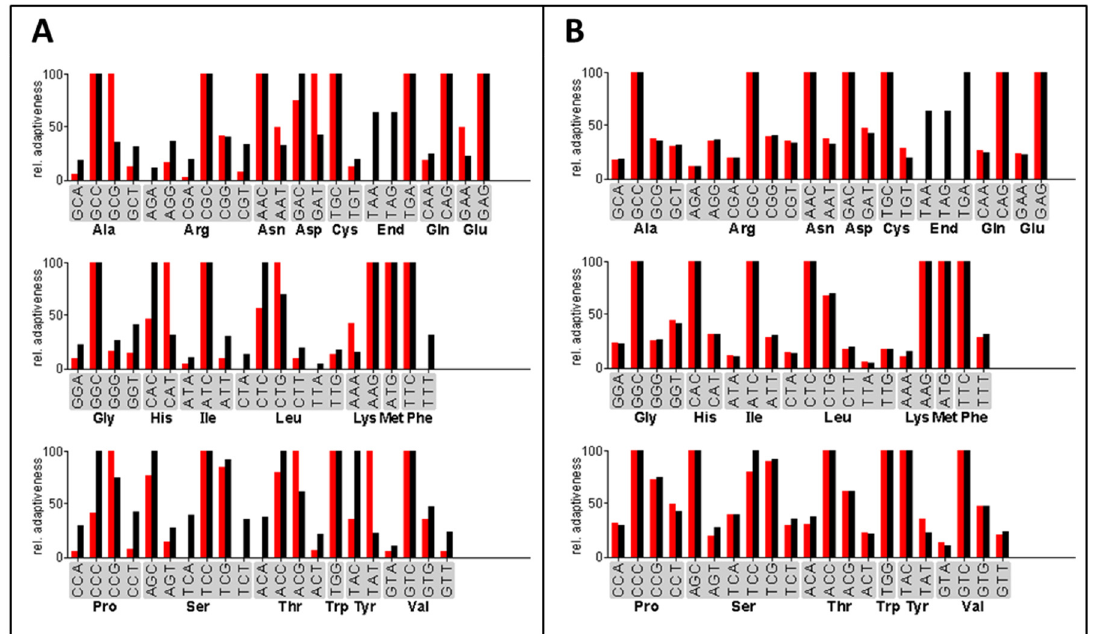
Figure 1. Example of the codon-optimizing process. Shown is the codon usage between the ccaC gene and the A. chrysogenum genome before ( A ) and after ( B ) codon optimization. The red bars represent the relative codon usage of the ccaC gene from Pseudomonas sp. GK16, the black bars indicate that of the A. chrysogenum genome database. The relative adaptiveness values of the various codons coding the same amino acid were normalized such that the most abundant one is 100%.